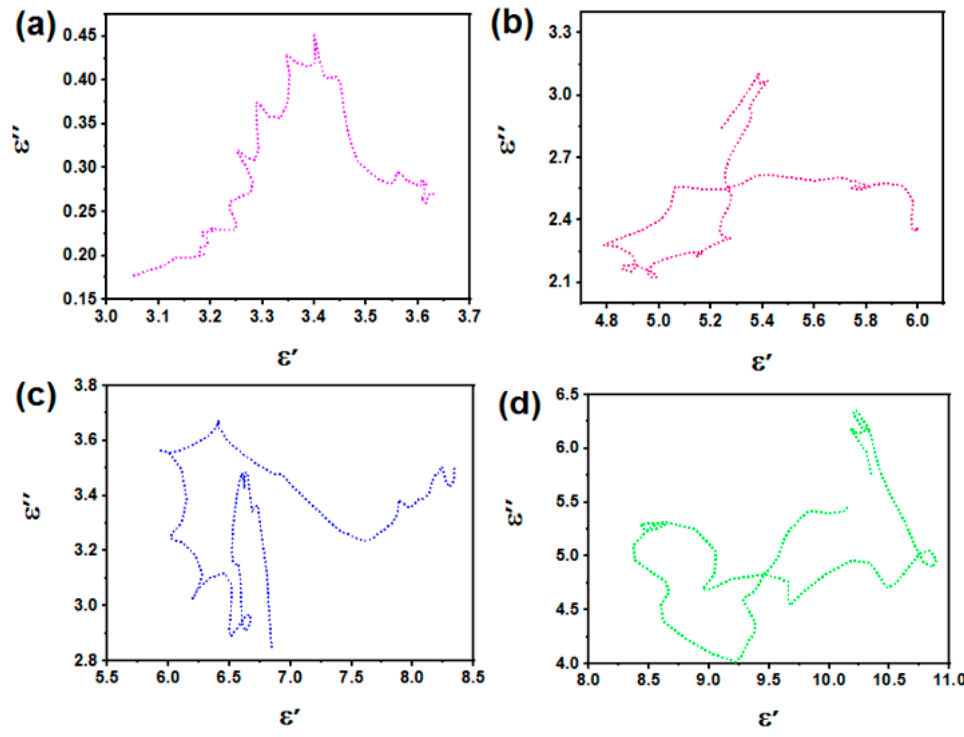
Figure 8. The Cole-Cole plots of ( a ) M0, ( b ) M10, ( c ) M20 and ( d ) M40.